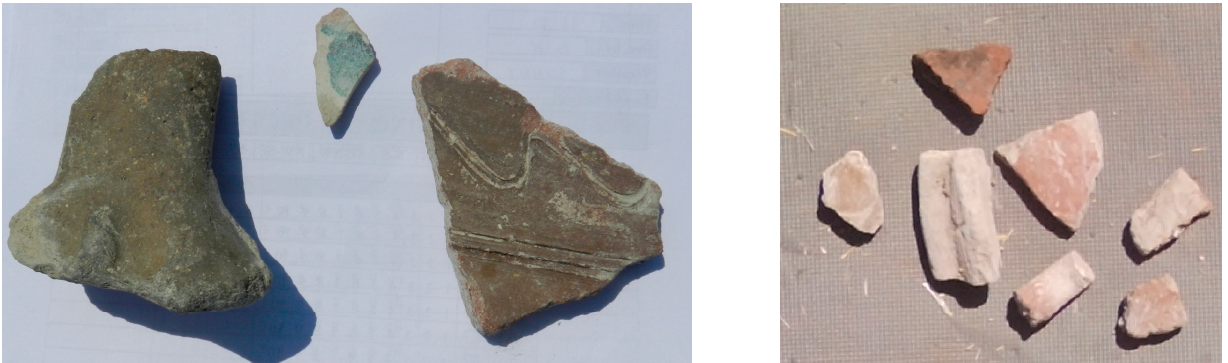
Figure 2. Examples of unwashed surface potsherds as recovered from the field in Areas 20 and 6, respectively (Photos: A. Vionis, ArtLandS Lab©).